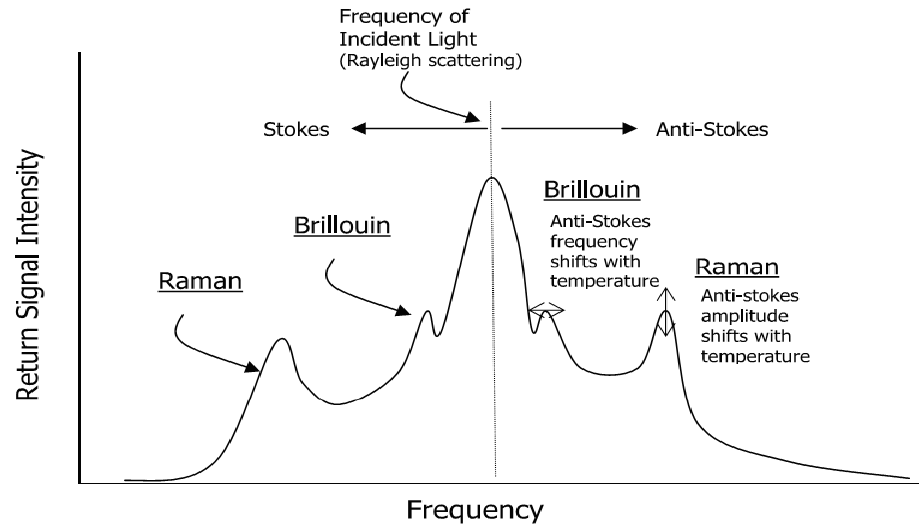
Figure 3. Schematic representation of the electromagnetic spectrum illustrating Rayleigh, Brillouin and Rayleigh scattering [66].